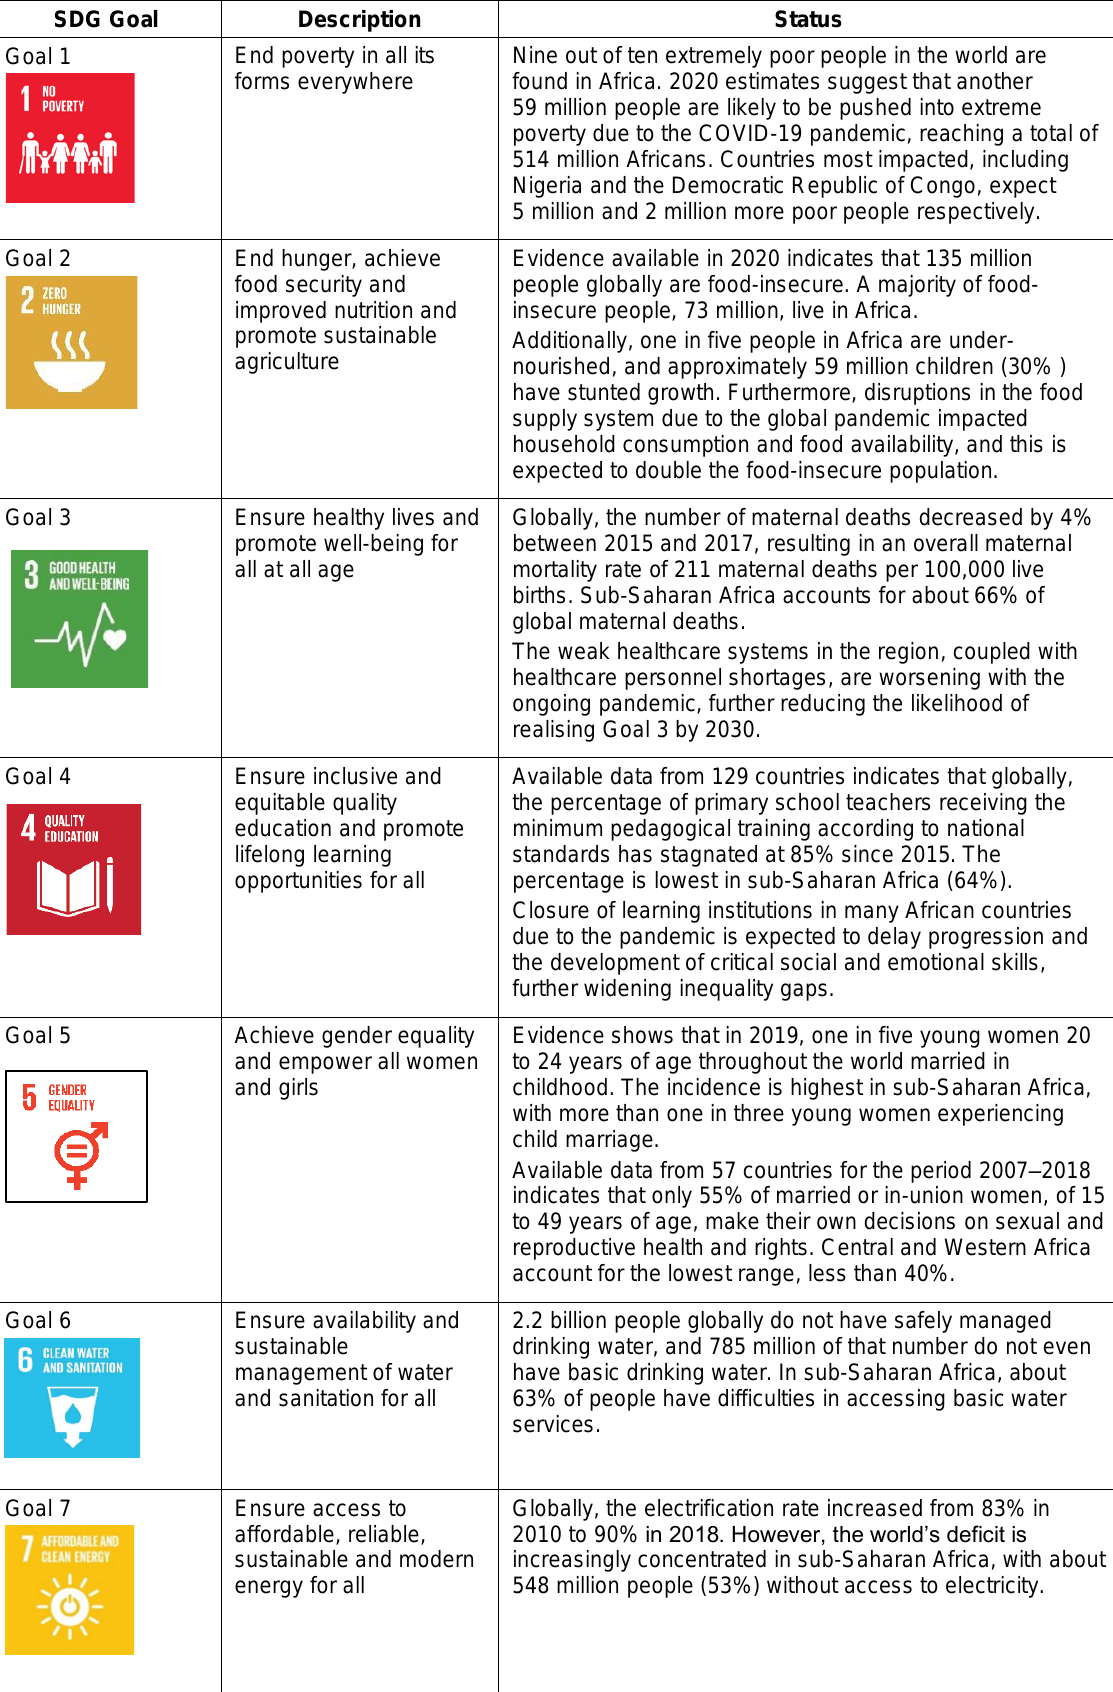
Table 3: Status of SDG indicators in Africa,